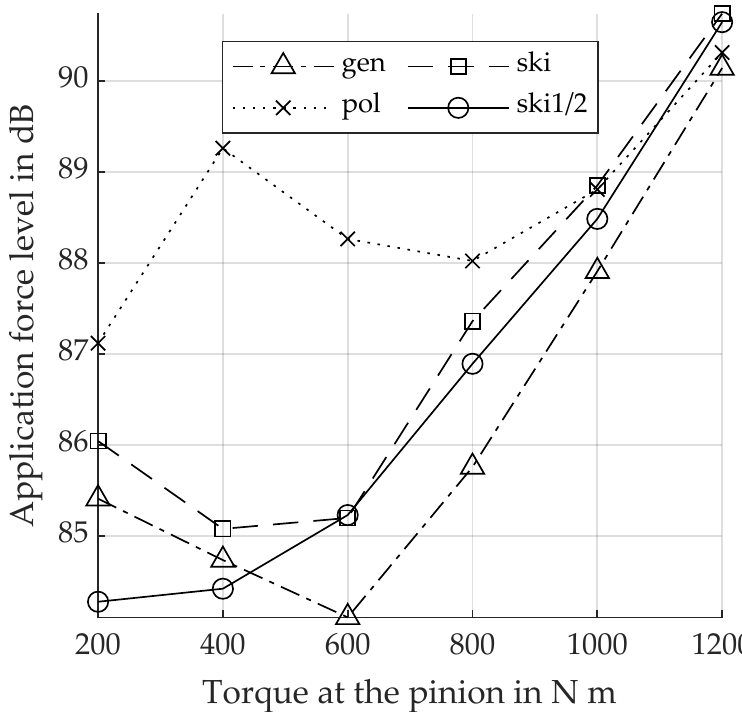
Figure 21. TCompensation curves of the application force level L A,F